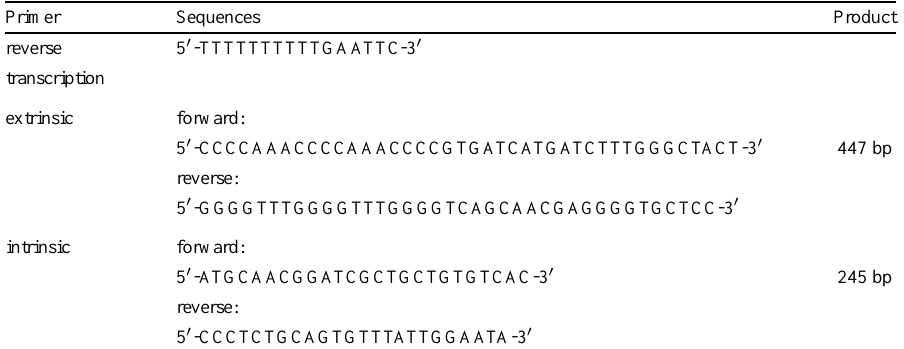
Oligonucleotides used in the present study as